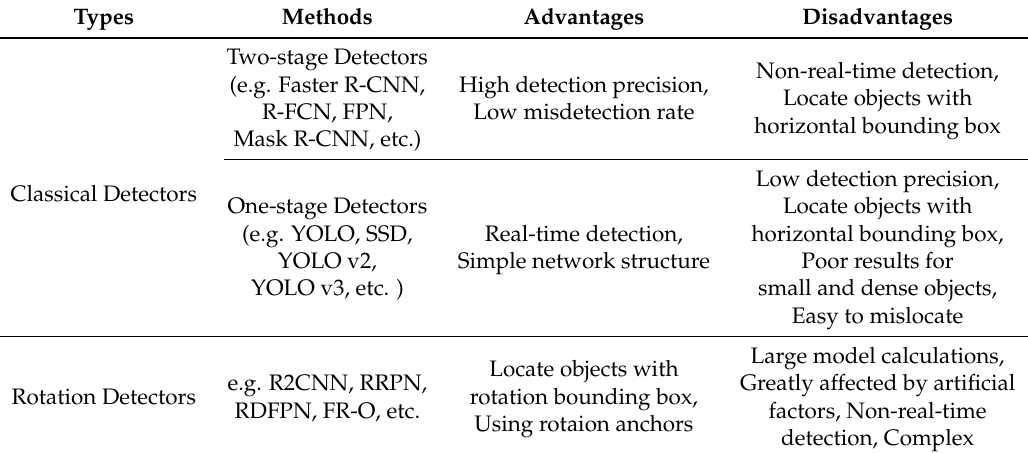
Table 1. The advantages and disadvantages of existing object detection methods.